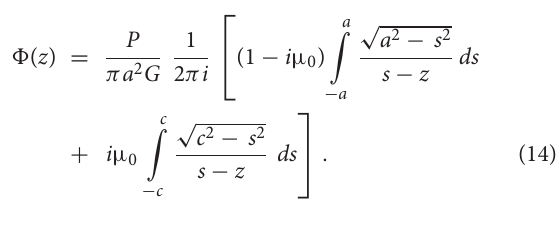
is determined by an equilibrium condition